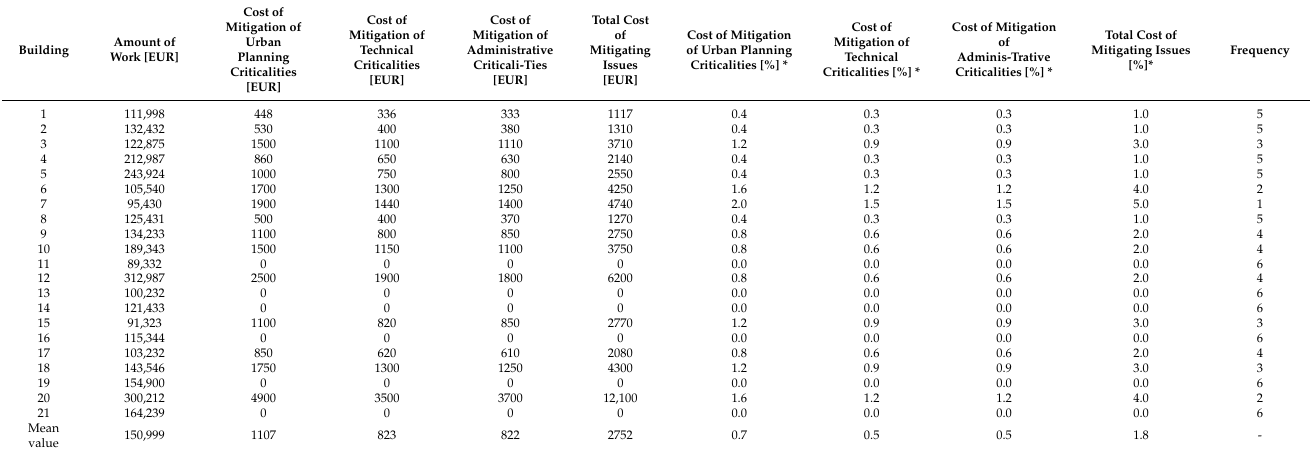
Table 7. Definition of the percentage costs of urban, technical, and administrative criticalities as a percentage of the amount of the works for the 21 projects carried out on multi-family buildings following the introduction of